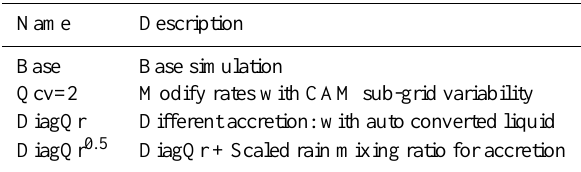
Table 1. Description of steady-state